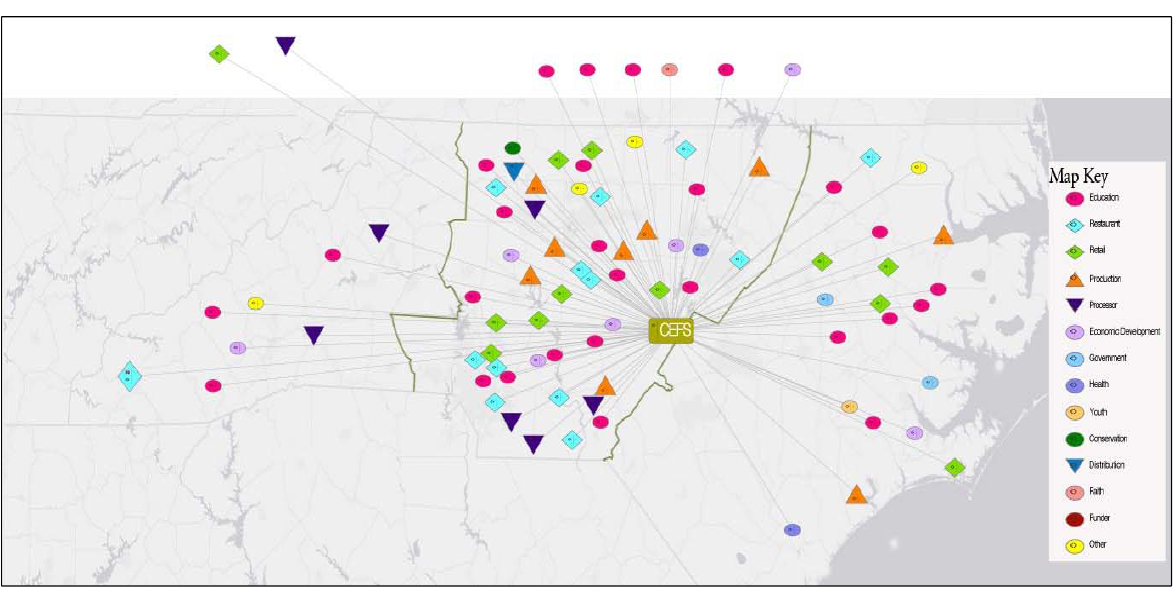
Figure 4. CEFS 2008 Network Map by Location and Type of Organization